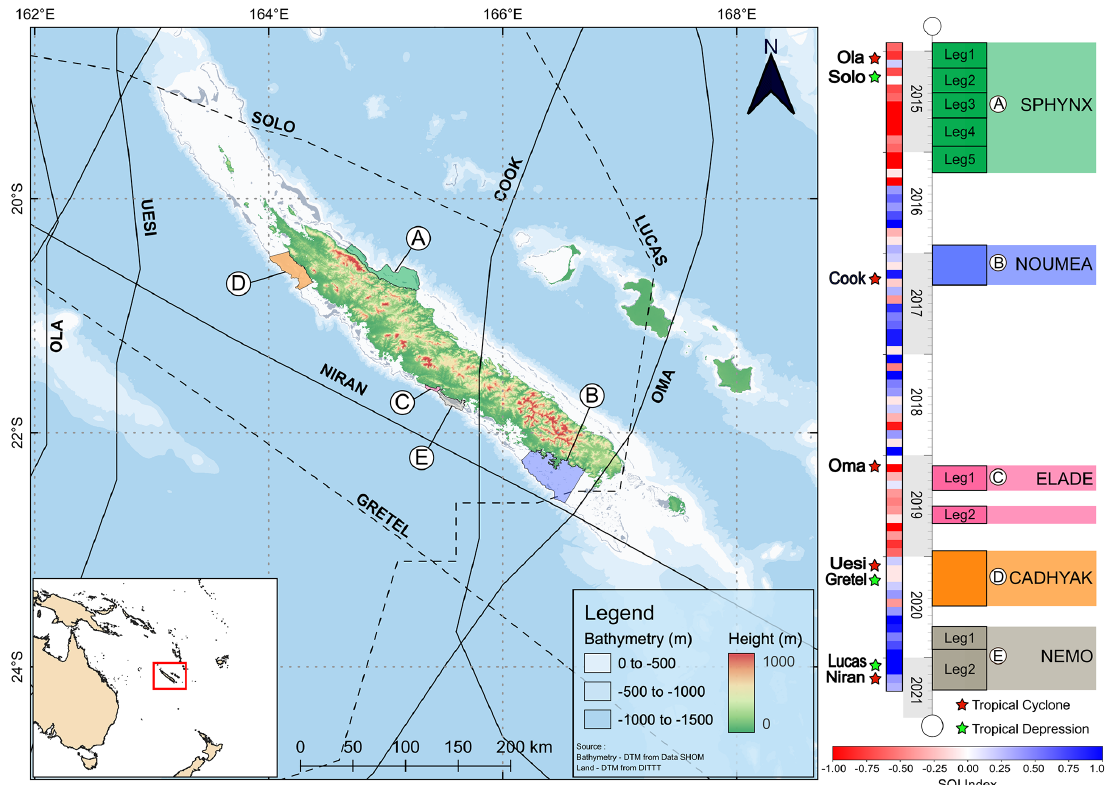
Figure 1. Map of New Caledonia including the location of the five studied lagoons: (a) SPHYNX, (b) NOUMEA, (c) ELADE, (d) CAD- HYAK, and (e) NEMO. Dashed lines and solid lines represent paths of tropical depressions and tropical cyclones, respectively. Chronology of the campaigns relative to the Southern Oscillation Index (SOI; blue: positive index, red: negative index) and the eight major atmospheric events (red stars: tropical cyclones, green stars: tropical depressions) are depicted to the right of the